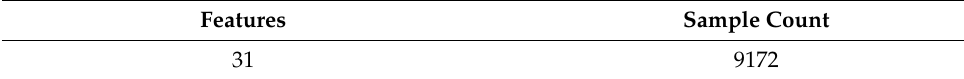
Table 2. Dataset